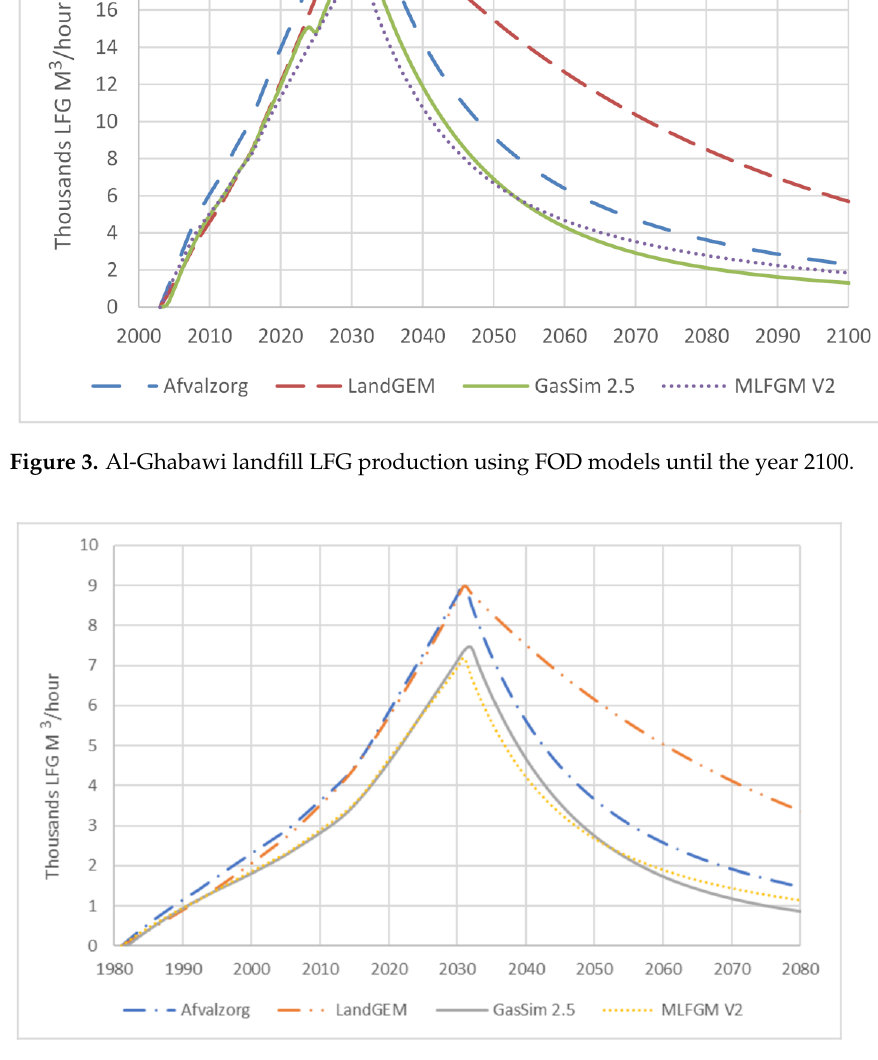
Figure 4. Al-Akeeder landfill LFG production using FOD models until the year